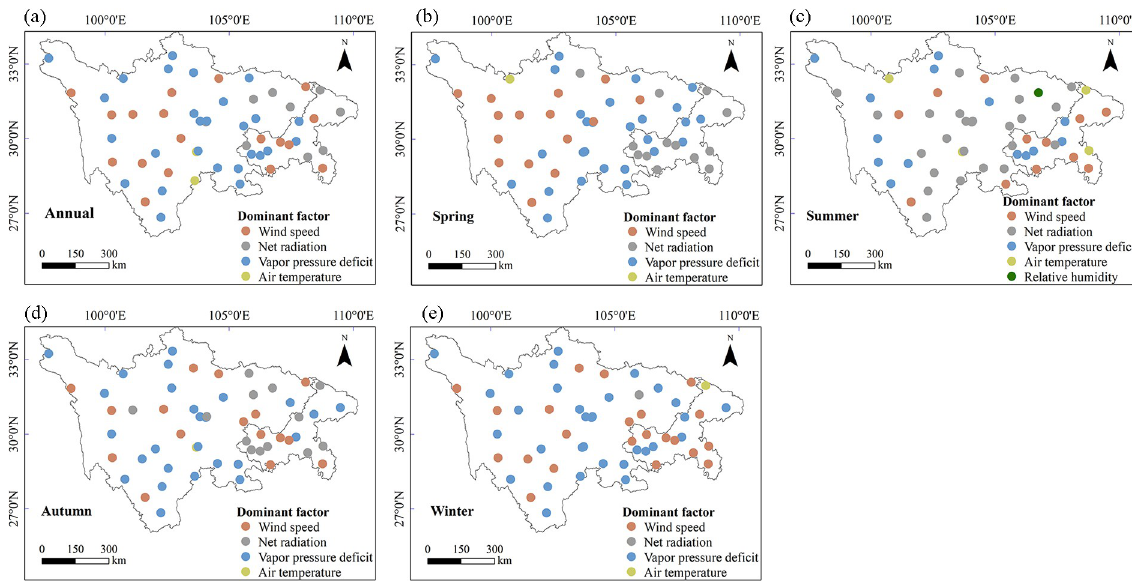
Fig 9. Spatial distributions of dominant factors of the change in PET in (a) annual, (b) spring, (c) summer, (d) autumn and (e) winter during 1970 − 2020.